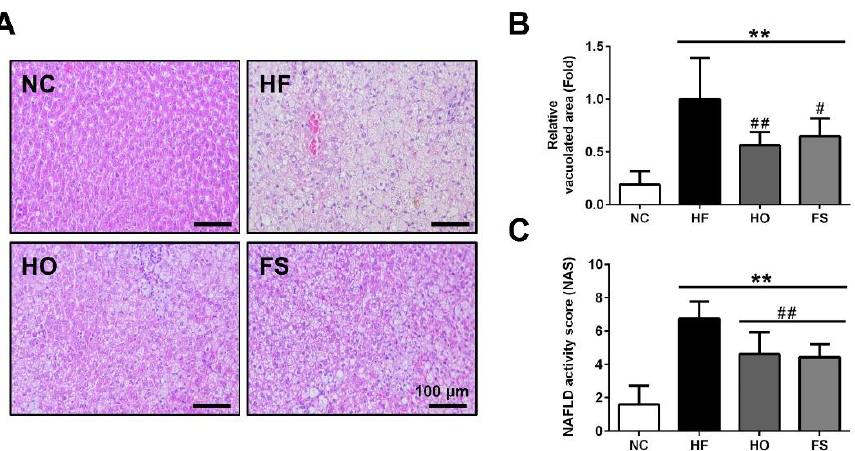
Figure 1. Effects of RMD and orlistat on the changes of hepatic histology in HF-diet-fed rats. Histological analysis in the livers of HF-diet-fed rats treated with or without RMD, and orlistat for 8 weeks was shown. ( A ) Representative hematoxylin and eosin (H&E) stained images of liver tissues were shown. ( B ) Relative vacuolated area and ( C ) NAFLD activity score (NAS) were quantified. Scale bar: 100 μm. * present p < 0.05, ** present p < 0.01 as compared with NC group; # present p < 0.05, ## present p < 0.01 as compared with HF group. NC: normal control diet; HF: high-fat diet; HO: high-fat diet containing 0.2% orlistat; FS: high-fat diet containing 5% Fibersol-2.